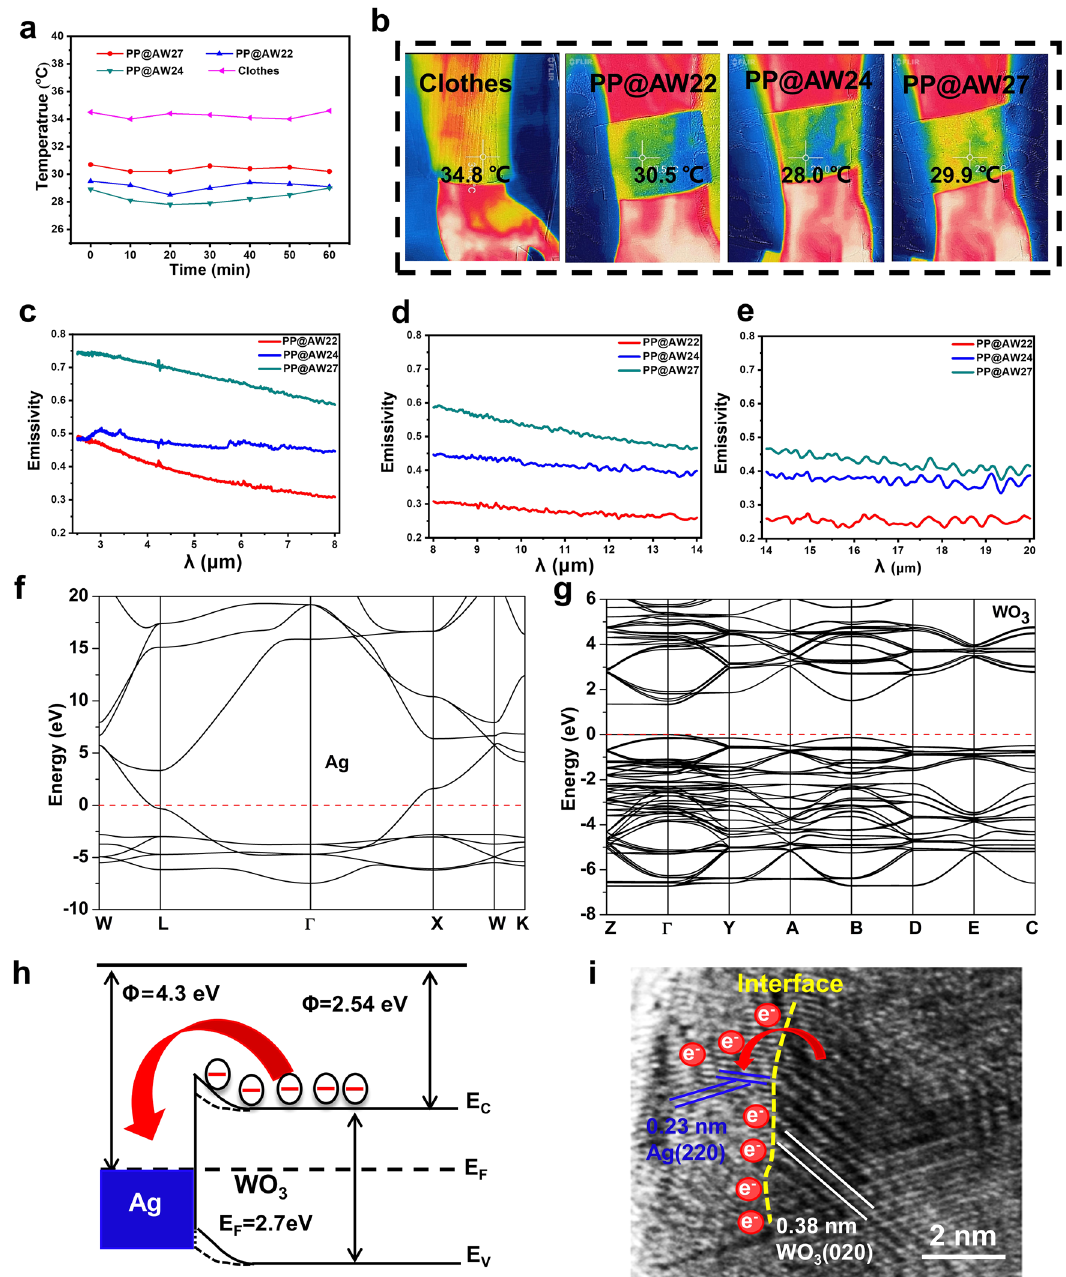
Fig. 4 IR-stealth properties of PP@AW hybrid membranes. a Changes in temperature of different hybrid membranes placed on the human body as a function of time and b IR digital camera images of clothes, and PP@AW22, PP@AW24, and PP@AW27 hybrid membranes placed on a human body. IR emissivity of PP@AW hybrid membranes in c near-, d medium- and e far-infrared bands, respectively. Energy band diagram of f Ag and g WO 3 . h Schematic illustration of the energy diagram and charge-transfer process in Ag-WO 3 nanoparticles. i Schematic illustration of electron transition when a Schottky junction is